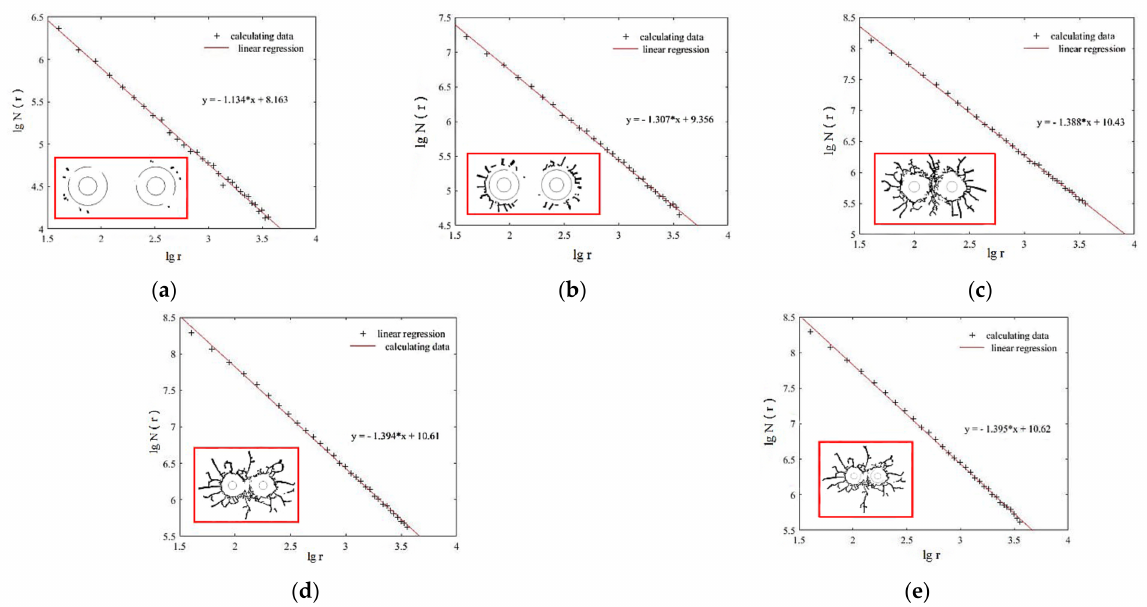
Figure 6. The 100 mm aperture, 700 mm aperture fractal dimension and damage evolution process. ( a ) At 1 us after explosion; ( b ) 2 us after explosion; ( c ) 3 us after explosion; ( d ) 4 us after explosion; ( e ) 5 us after